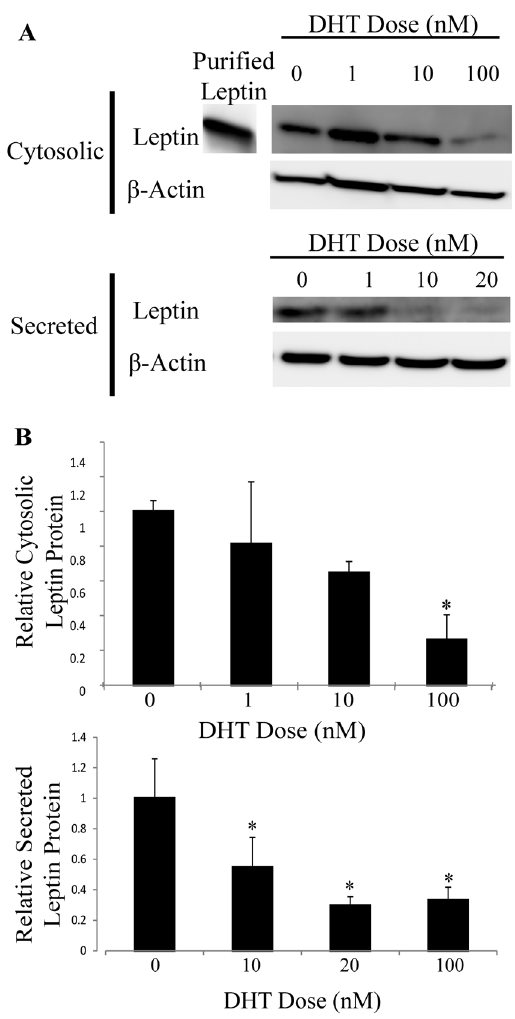
Figure 3. Leptin levels significantly decreased in both cell extracts and supernatants from cells treated with 1–100 nM DHT. Cells were treated with DHT for 24 hours after a 6 hour serum deprivation. ( A ) Cytosolic proteins were quantified in a cell extract and supernatants were collected for analysis with Western blots with a leptin-specific antibody. ( B ) Protein levels were normalized to actin and are reported relative to the untreated control with n ≥ 5 biological replicates; * Denotes p-value ≤ 0.05 when compared to control with 2-sample, independent Student’s t-tests. The blots in this image are cropped and full length images are shown in Supplemental Figs 3 and 4.